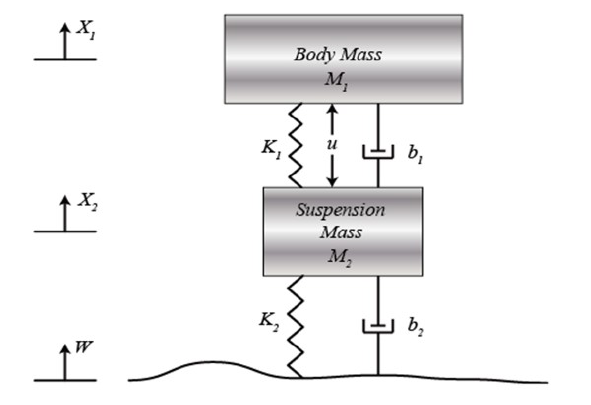
Figure 3. Semi - Active Suspension for Quarter car Model [4]